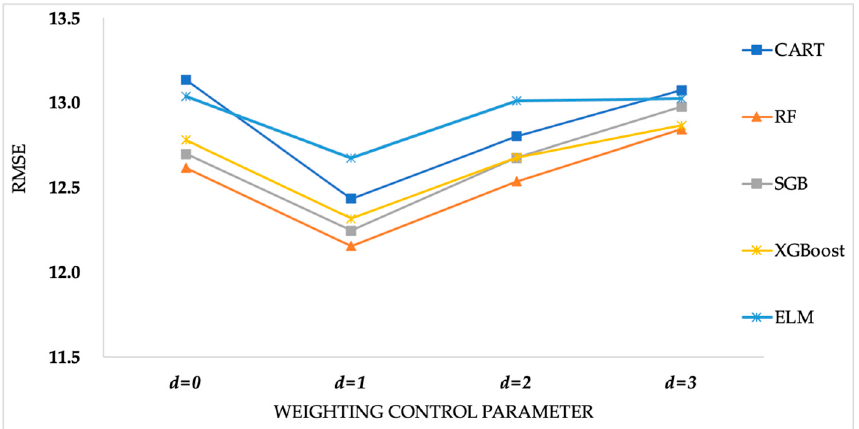
Figure 8. Prediction performance of prediction models with weighting control parameter ( d ) from 0 to 3 under game-lag ( l ) = 5.